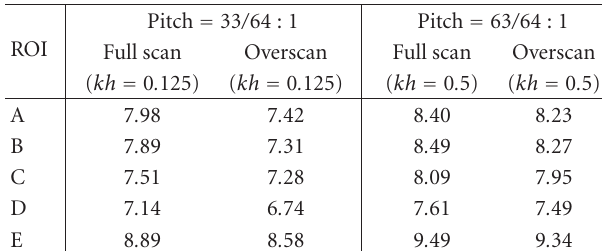
Table 1: Noise measurement of the ROIs specified in Figure 5 at helical pitches 33 / 64 : 1 and 63 / 64 : 1,